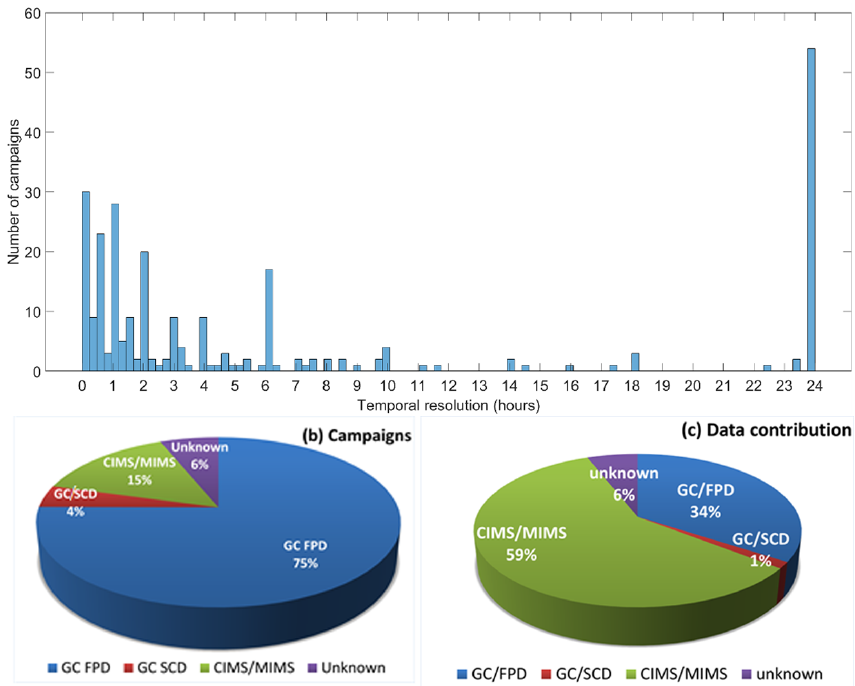
Figure 2. (a) Frequency distribution of the sampling interval for the campaigns included in this study are shown. Note that the “24h” bin represents temporal resolution lower than or equal to 24h. (b) The type of measurement technique used to measure DMS during the individual campaigns. The unknown dataset/campaigns resemble the frequency of a GC instrument. (c) The number of raw data points according to the measurement technique is shown. The number of data is dominated by CIMS/MIMS based measurements, but the number of campaigns is dominated by the GC